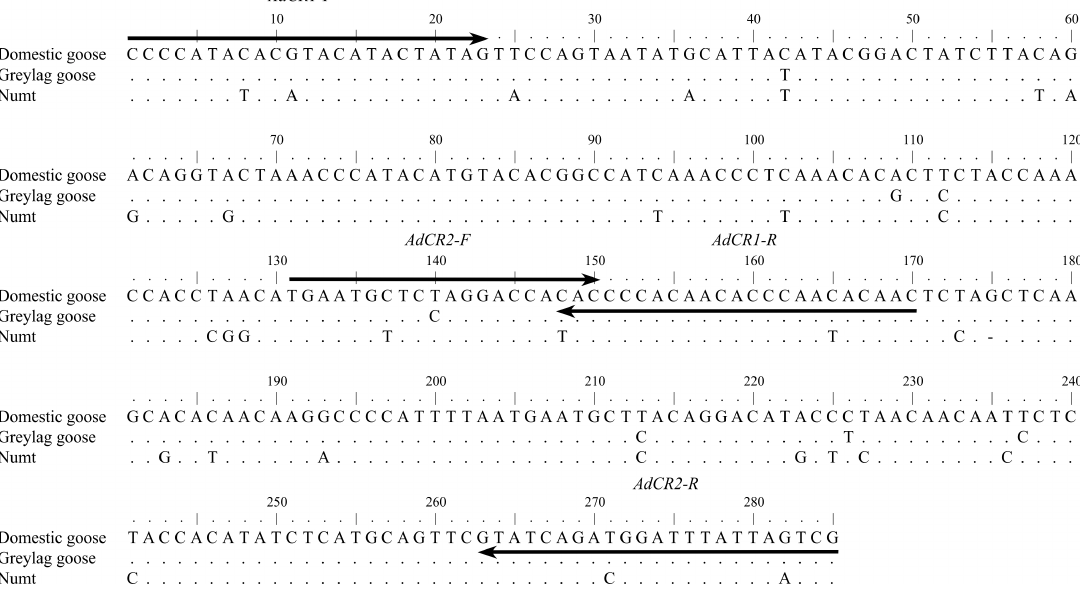
Figure 2. Alignment of domestic goose (GenBank accession number: GQ120441), greylag goose (AF159961) and Numt (nuclear sequence of mitochondrial origin; AF159970) sequences of the hypervariable part of the mitochondrial control region domain I (285 bp). The designed primer pairs AdCR1 and AdCR2 are shown as black arrows. The primer sequences were removed, and the remaining two fragments were concatenated for later analysis.